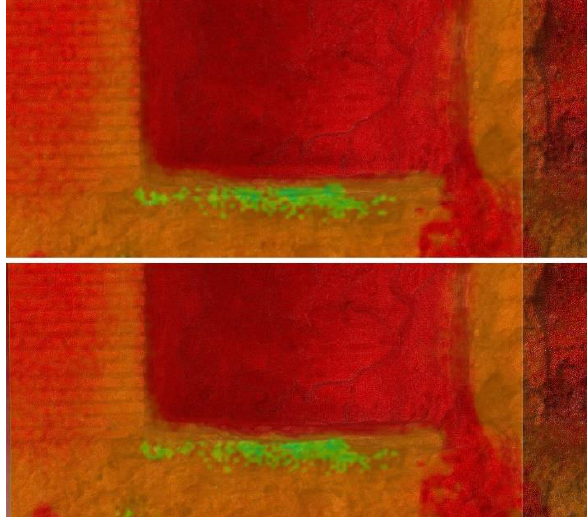
Figure 9. Top: IR camera rendered on the point cloud in its original position. Down: IR camera rendered on the point cloud after the 4cm down translation The second approximation was verified in the acquisition phase avoiding the rolling of the devices. This operation provoked a substantial coincidence between the global z axis and local z axis. During the survey phase, the calculation of the Ground Sample Distance (GSD) of the IR images provided the reference parameter in terms of margin of uncertainty allowed for the mapping operation. The GSD is about 7 mm/px, with a field angle of 32°, at 2 m distance (Fig. 10). This approximate value is suitable with the projective operations